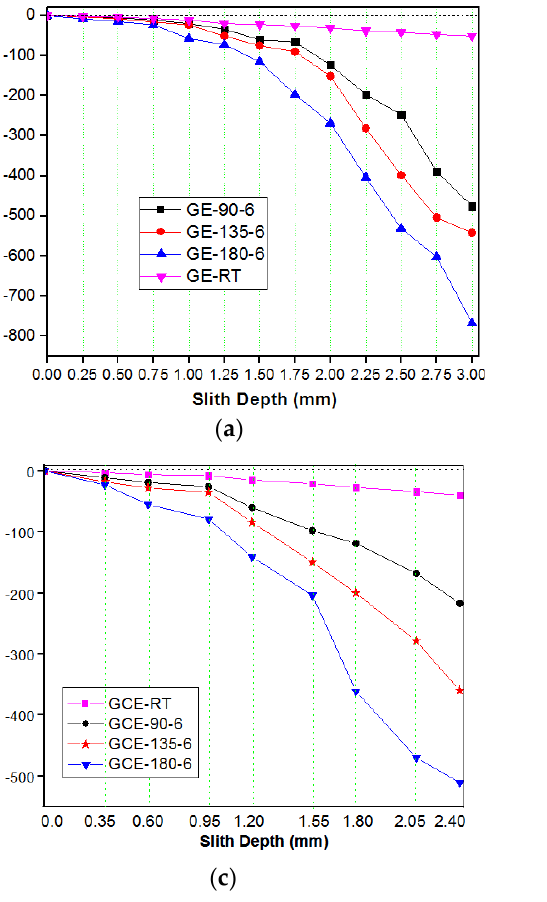
Figure 3. Schematic illustrations of ( a ) Slitting specimen with a bonded strain gage. ( b ) Experimental setup for the slitting experiment. ( c ) Relative position of strain gage and cutter ( d ) Relative position of cutter and slit. ( e ) Slitting specimen used for determination of longitudinal residual stress. ( f ) Slitting specimen used for determination of transverse residual stress.